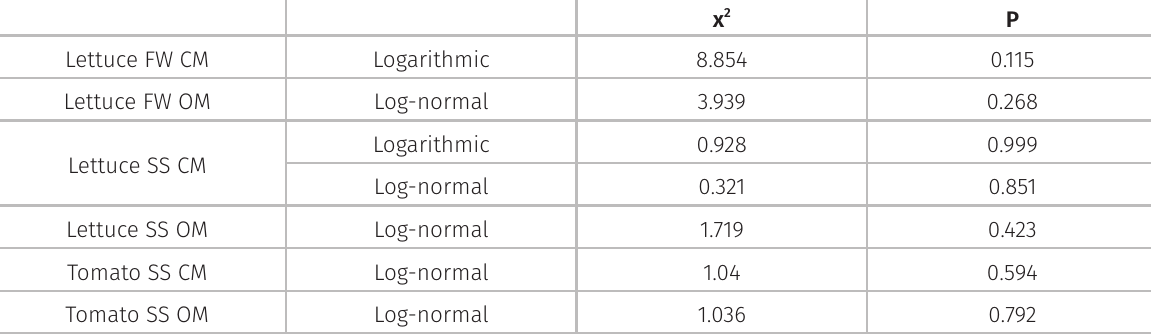
Crop cycles: FW, fall-winter; SS, spring-summer; Plant protection measures: CM, conventional management of pests, use of agrochemicals; OM, organic Table V. Similarity Sørensen quantitative indexes, calculated using specific composition and abundance of epigeic coleopteran species belonging to Carabidae, Curculionidae, Staphylinidae and Coccinellidae families (see also Fig. 4). Years: 2010-2013. LT: lettuce; TOM: tomato; FW: fall-winter; SS: spring-summer; CM: conventional use of pesticides; OM: organic farming. LT FW CM